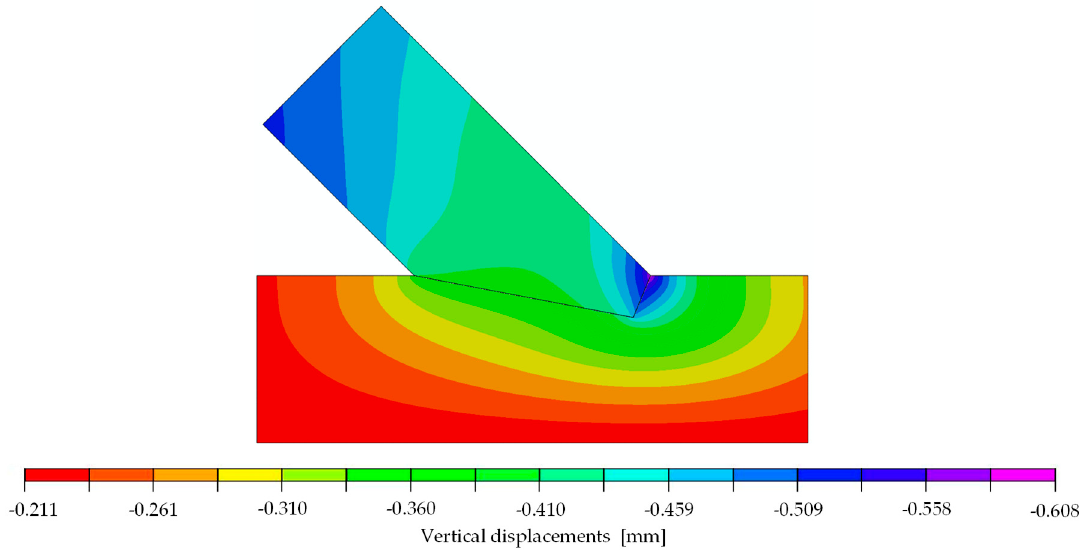
Figure 9. Vertical displacements of numerical model at 29.6 kN [mm].